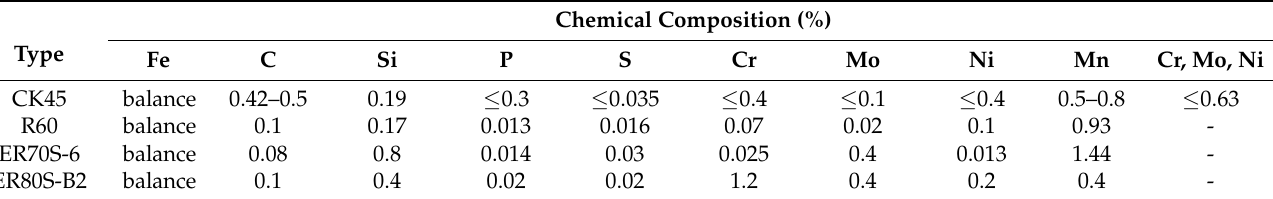
Table 1. Nominal chemical compositions of CK45 carbon steel plates and filler metals.